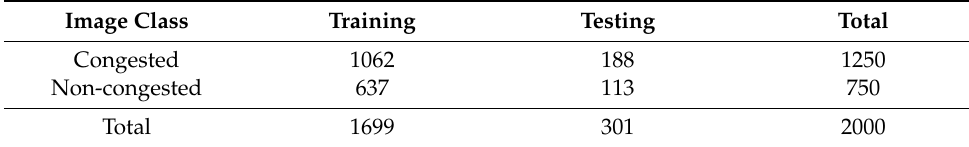
Table 2. Distribution of the image dataset for training and testing.